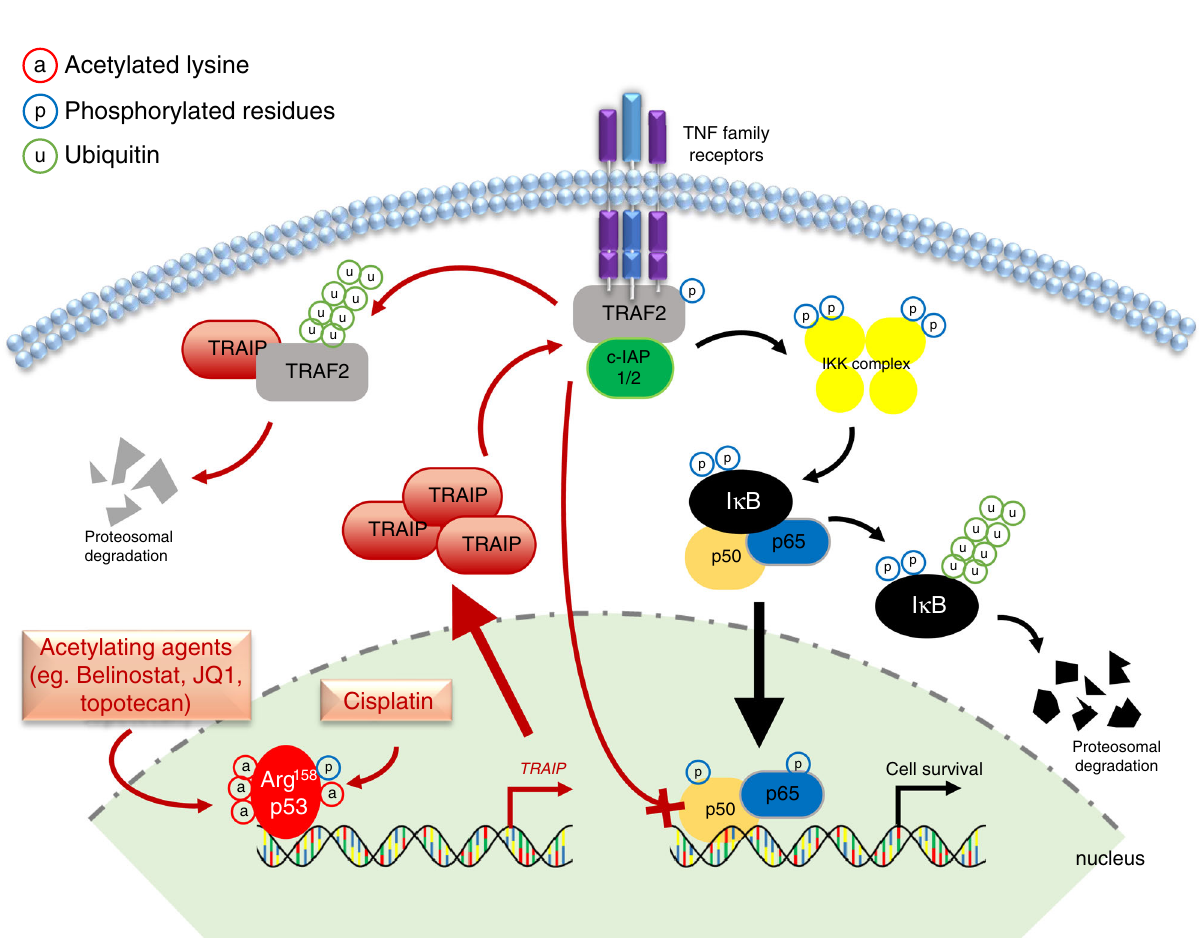
Fig. 8 Proposed mechanism of Arg 158 mutp53 in response to treatment with acetylating agents. Tumor cells harboring mutp53 expressed inherently high level of NF ĸ B activity to confer cellular survival. We showed that in mutp53 R158G cells, NF ĸ B/p65 signaling could be suppressed through negative regulation of the TRAF2/c-IAP/I ĸ B-axis via the upregulation of TRAIP, which is induced transcriptionally by monotherapy or combination treatment of compounds shown to induce mutp53